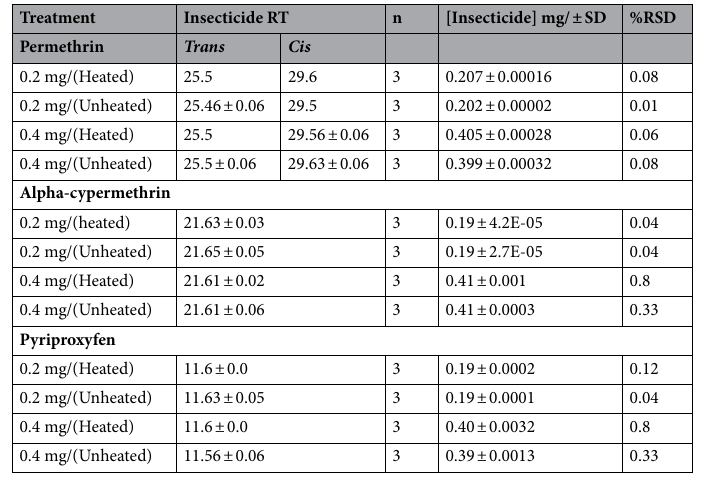
Table 4. Stability of permethrin and pyriproxyfen active ingredients heated at 85 °C for 45 min. RT insecticide peak retention time, n the number of replicates, SD Standard deviation, %RSD relative standard deviation